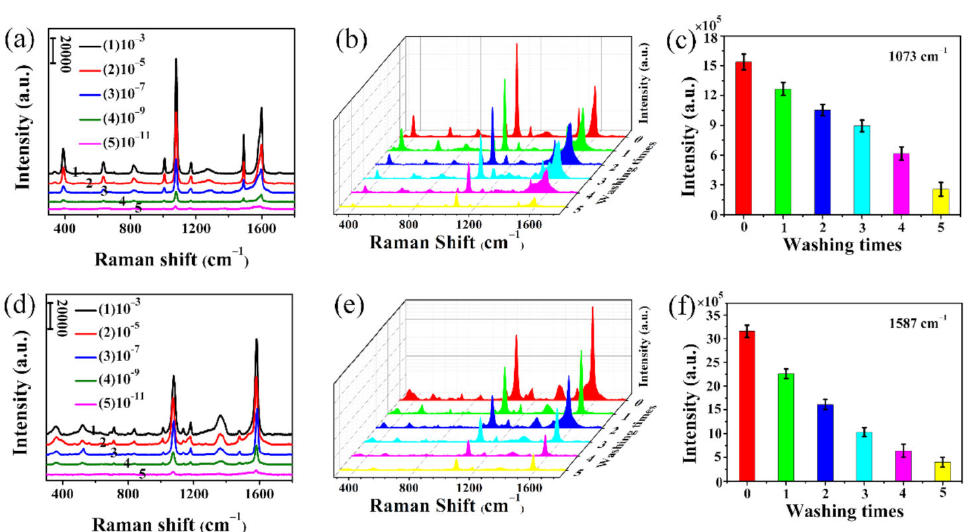
Figure 8. SERS spectra of Ag@T-A@SiO 2 @Au-20 substrates measured with 10 − 3 –10 − 11 mol / L 4-MPh ( a ) and 4-MBA ( d ); SERS spectra of Ag@T-A@SiO 2 @Au-20 substrates measured with 10 − 5 mol / L 4-MPh ( b ) and 4-MBA ( e ) for 5 consecutive cleaning; the peak intensity at 1073 cm − 1 for 4-MPh ( c ) and 1587 cm −